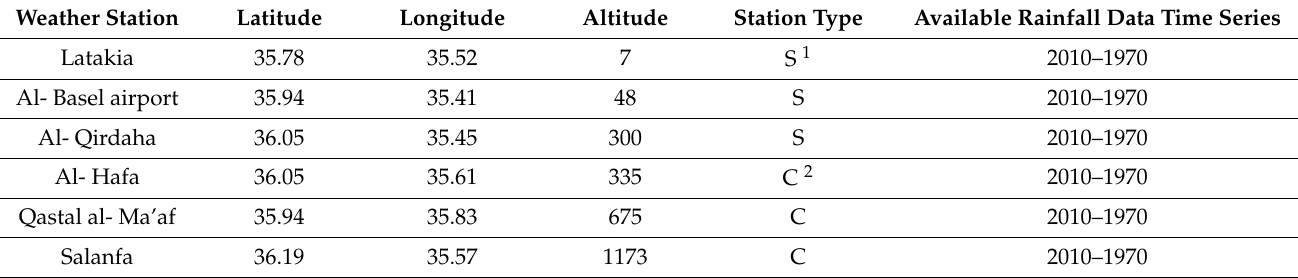
Figure 1. Location of Latakia Governorate in Syria, with the location of the six weather stations. Table 1. Names, locations, and altitudes of weather stations used in the study